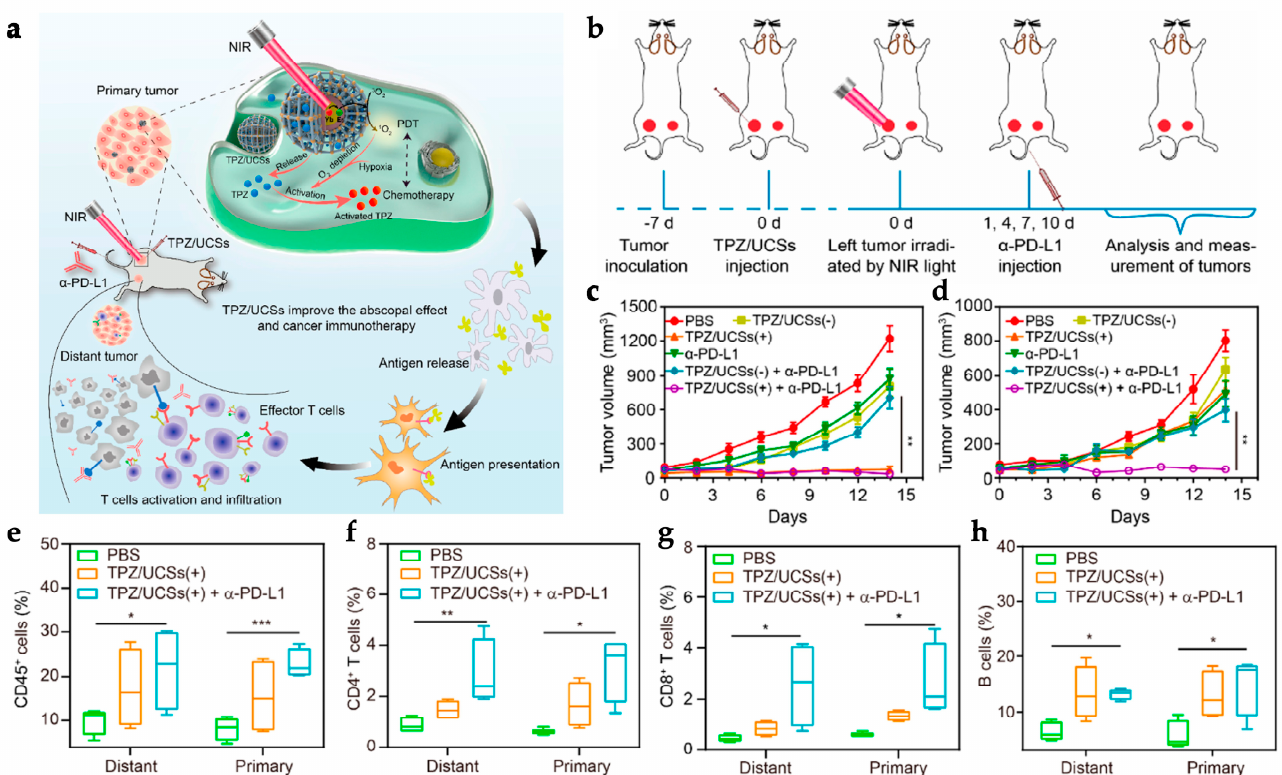
Figure 4. MOFs used for synergetic PDT-immunotherapy ( a ) TPZ/UCS promoted UCNP core up conversion luminescence to Zr-MOF shell enhancing PDT. TPZ encapsulated in Zr-MOF nanopores is activated by hypoxia synergizing with PDT for ICD induction. Antigen release activates immune response. The combination with α -PD-L1 further increased antitumor immune response. ( b ) CT26 tumor cells inoculated in a bilateral tumor model in mice (grown to 50–100 mm 3 ). Mice were treated with UCS/TPZ (25 mg/kg) and UCS laser irradiated (980 nm, 1.2 W/cm 2 ) for 20 min (5 min break after 1 min irradiation). 750 μ g/kg α -PD-L1 was injected on days 1, 4, 7, and 10 after treatment. ( c , d ) Tumor growth curves of the primary ( c ) and distant ( d ) tumors in different treatment mice. ( e – h ) Percentage of infiltrating CD45 + cells, ( e ) CD4 + T cells, ( f ) CD8 + T cells ( g ), and B cells ( h ) in total tumor cells in primary and distant tumors. Data are means ± SD. * p < 0.05, ** p < 0.01, and *** p < 0.001. Adapted with permission from [135]. Copyright © 2020 American Chemical Society. from environmental or genetic factors, as well as nutrient deprivation and aging. The various processes culminate in the degradation of the damaged intracellular